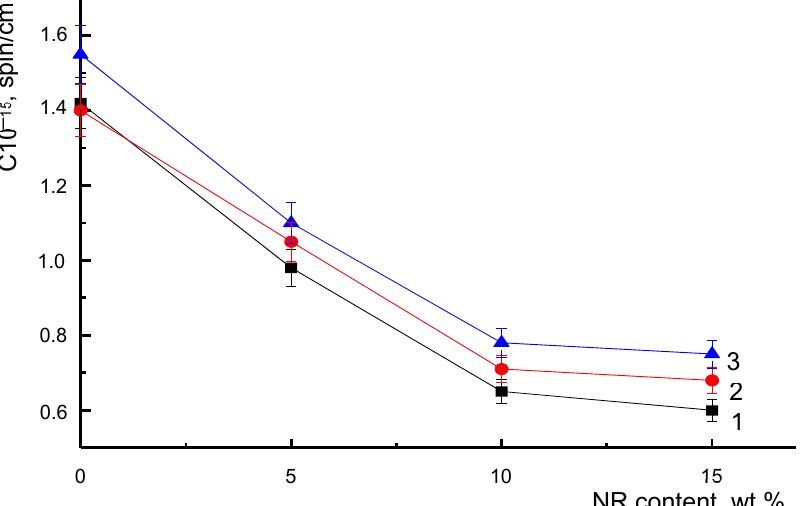
Figure 6. Radical concentration in PLA/NR fibers of initial (1) and after 60 days (2) and 220 (3) of soil exposure.